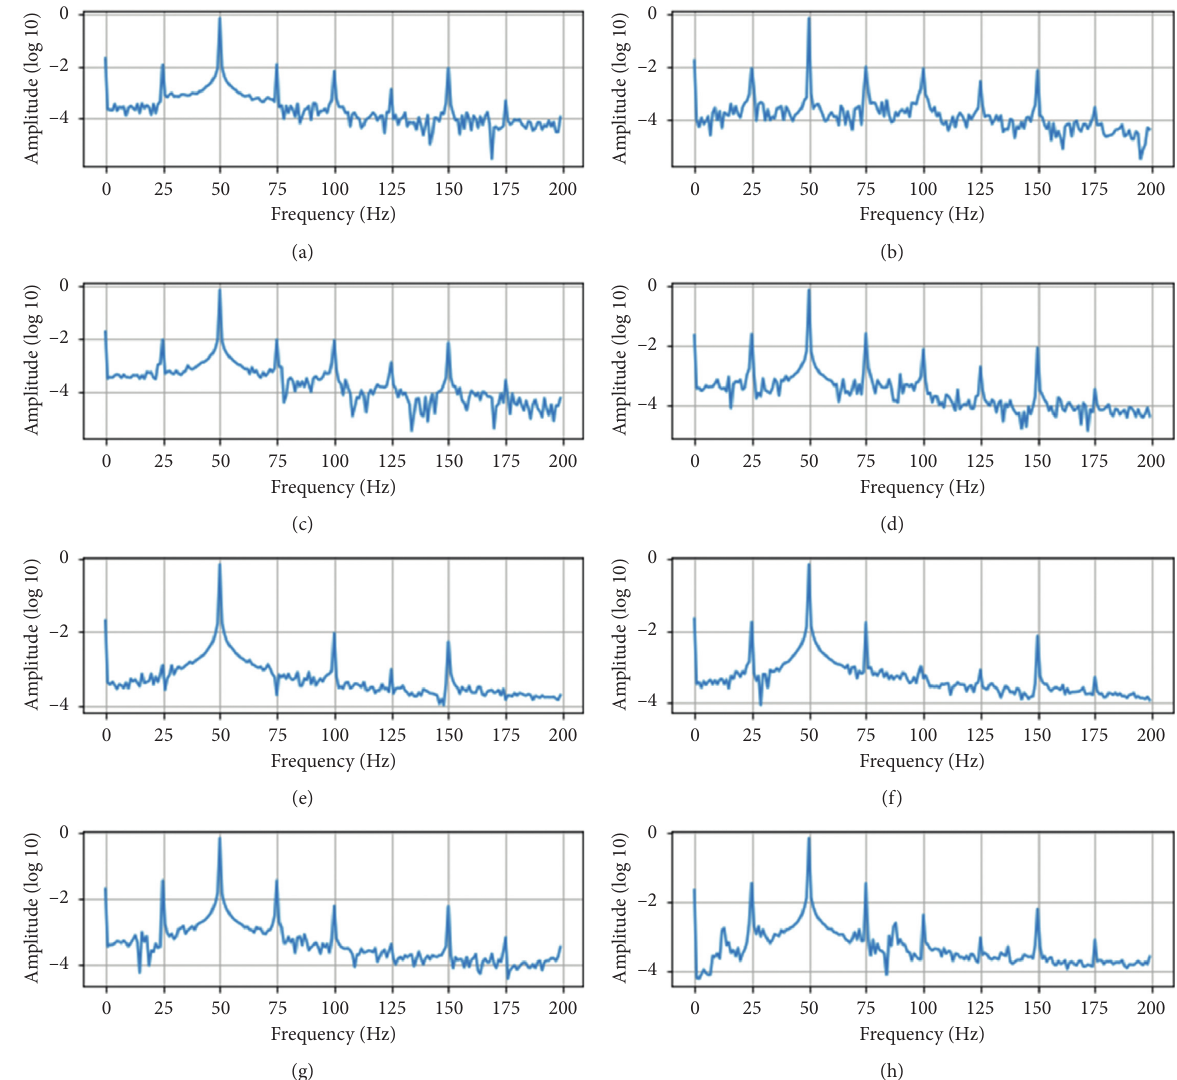
Figure 4: Amplitude spectrum analysis of different types of faults. (a) Bearing inner race fault, (b) bearing outer race fault, (c) bearing ball fault, (d) planet gear fault, (e) planet bearing inner race fault, (f) sun gear fault. (g) ring gear fault, and (h) no